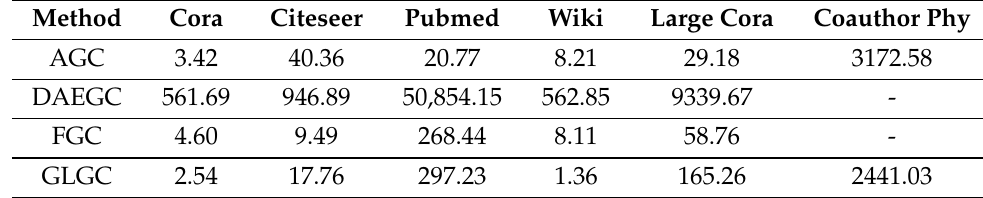
Table 3. Time cost of the representative methods (in seconds).